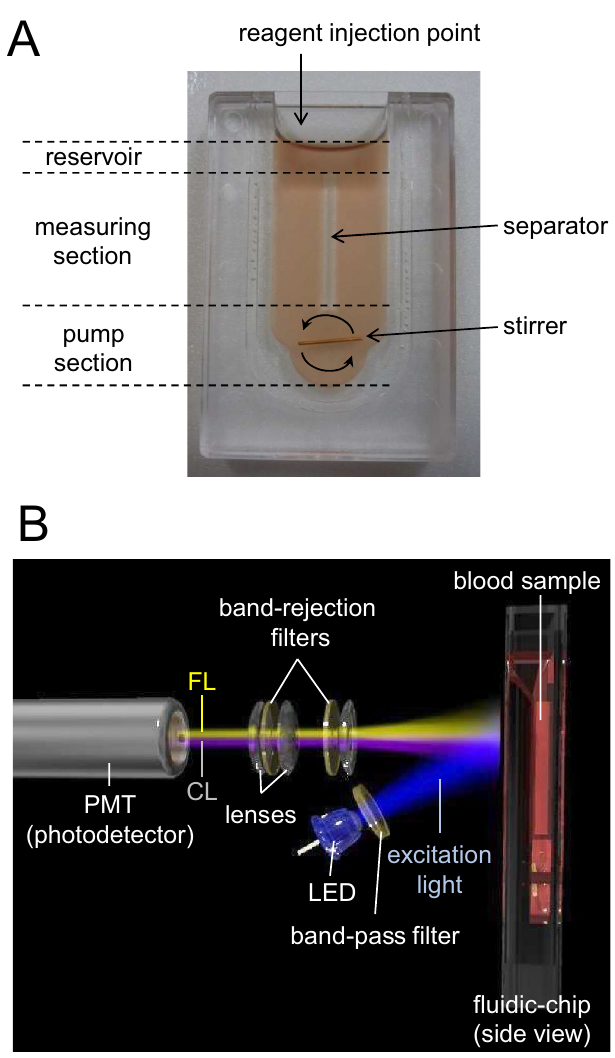
Figure 1. The fluidic-chip and optical configuration for the new system. ( A ) A picture showing the structure of the fluidic-chip (outer dimensions: width 28 mm, thickness 6 mm and height 41 mm; inner dimensions: width 13.4 mm, thickness 2 mm and maximum depth 33.5 mm; internal sample volume: 750 µL). ( B ) A schematic diagram of the optical configuration for CFL-H2200 and -H2400 models. Detailed explanations are described